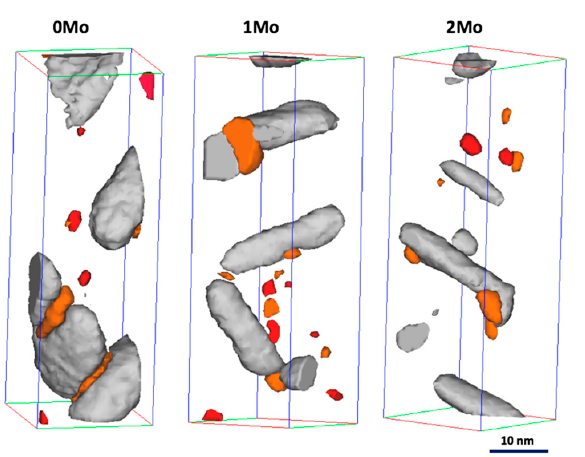
Table 5. Composition of the matrix of the investigated materials (at.%), with Fe as